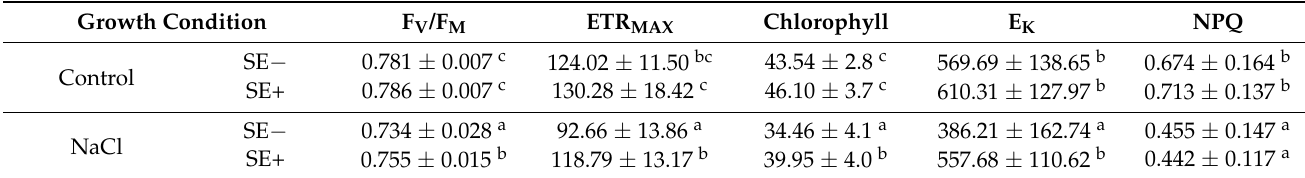
Table 2. Photosynthetic parameters of the tomato plants grown under salinity stress.